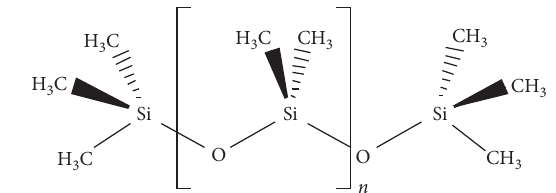
Figure 1: Structure of Siluron 5000.